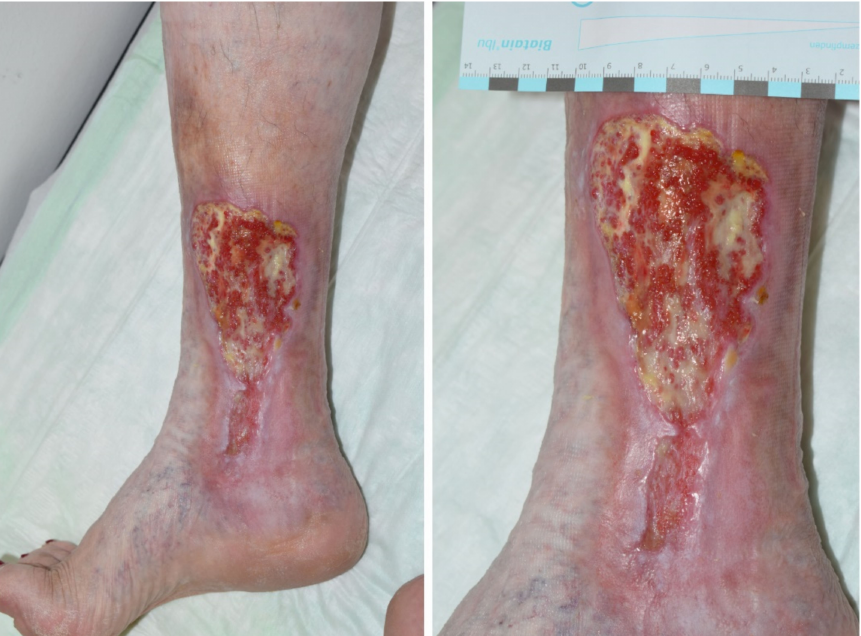
Figure 1. Chronic venous leg ulcer typically located at the inner malleolus due to varicosis of the vena saphena magna. Note all three stages of chronic venous insufficiency according to Widmer: Corona phlebectatica at the bottom of the ulcer (Widmer stage I), liposclerosis with brownish hyper- pigmentation at the top of the ulcer, atrophie blanch é and purpura jaune d’ocre (Widmer stage II) as well as the ulcer itself (Widmer stage III). Left: overview; right: detailed